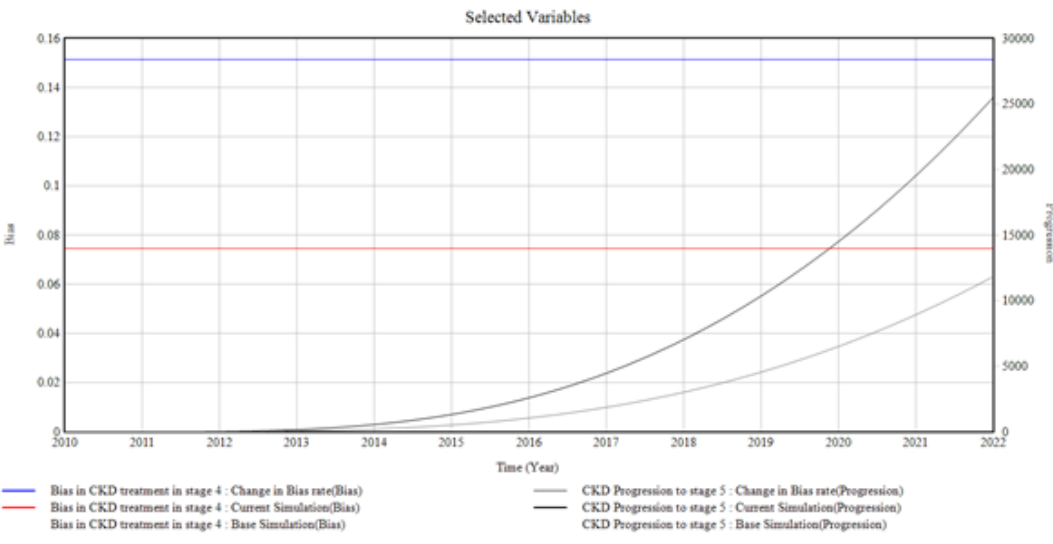
Figure 6. The Bias Rate in Stage 4 CKD vs. CKD Progression to Stage 5